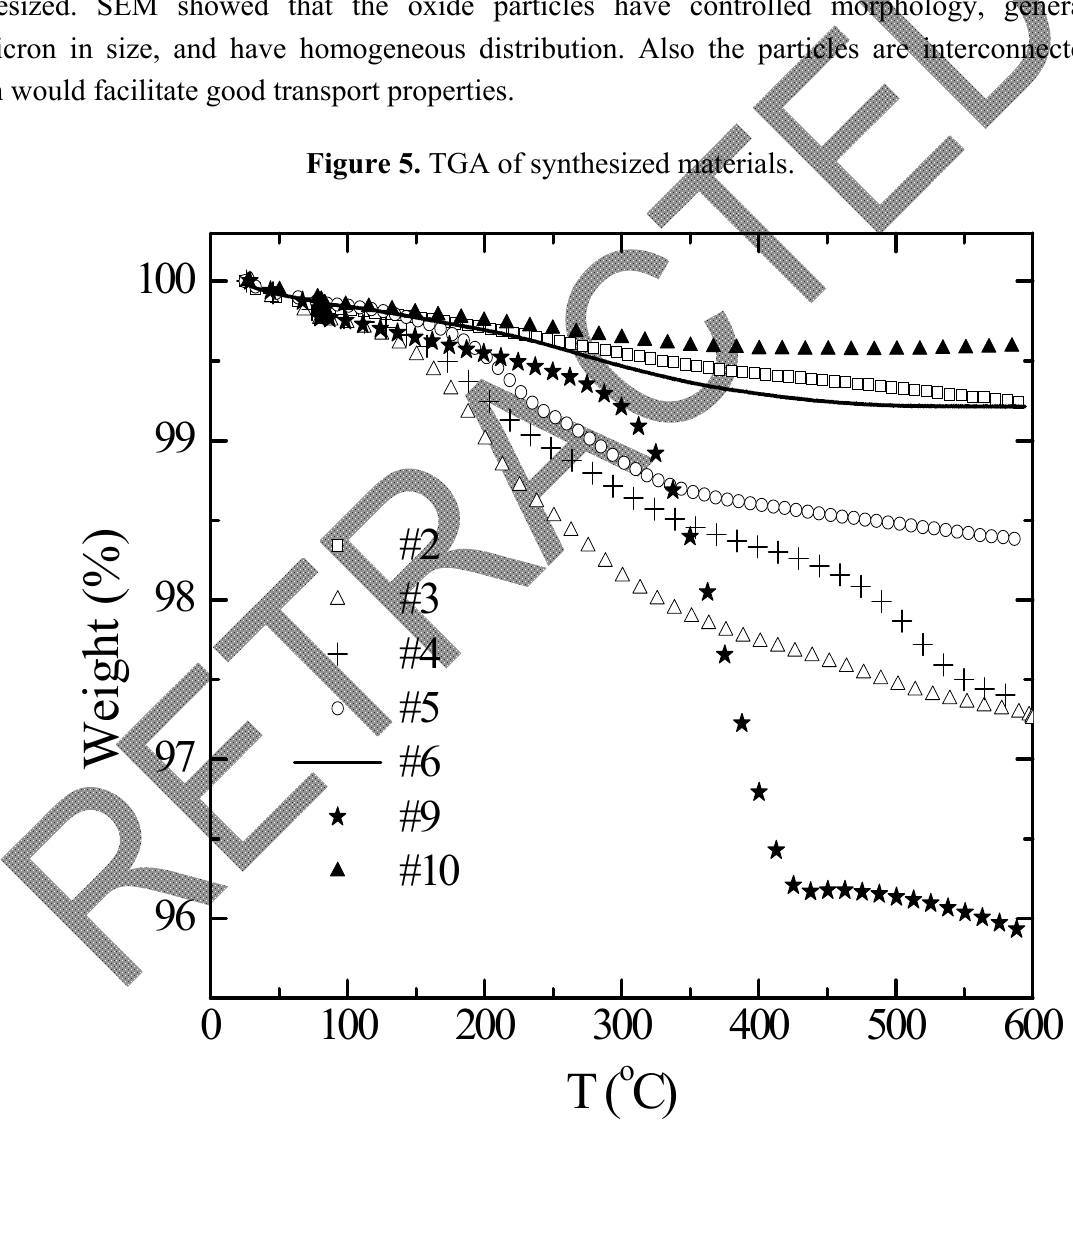
Figure 5. TGA of synthesized